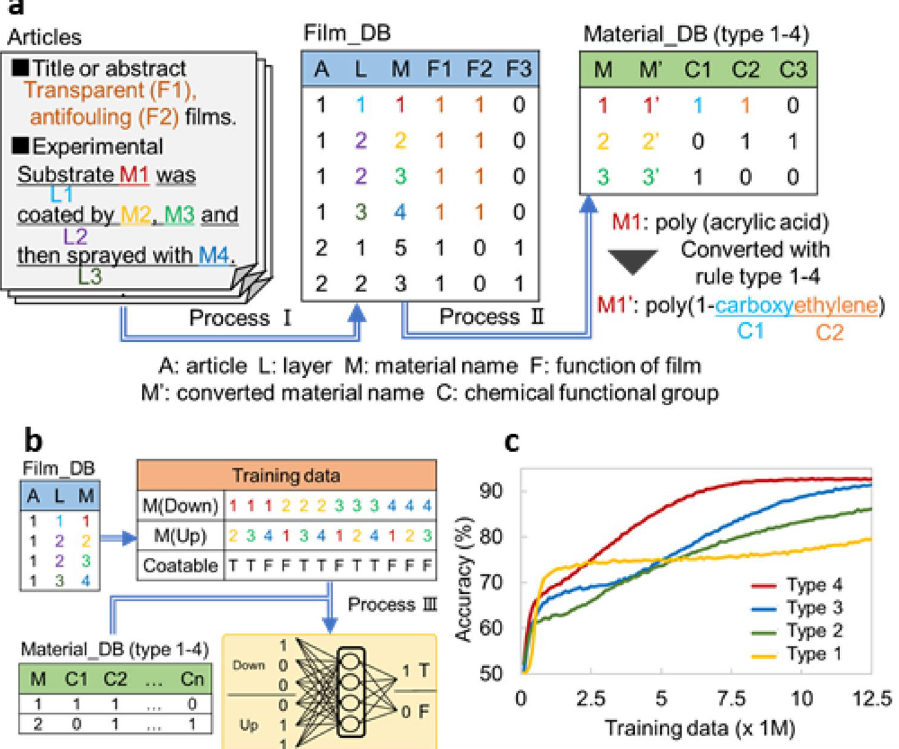
Figure 2. Data collection and learning by different material descriptors. ( a ) Data extraction process for layered structure and functionalities. ( b ) Process for learning film formation property through training data. ( c ) Accuracy of judgment results with four different material descriptors with increasing total training data.